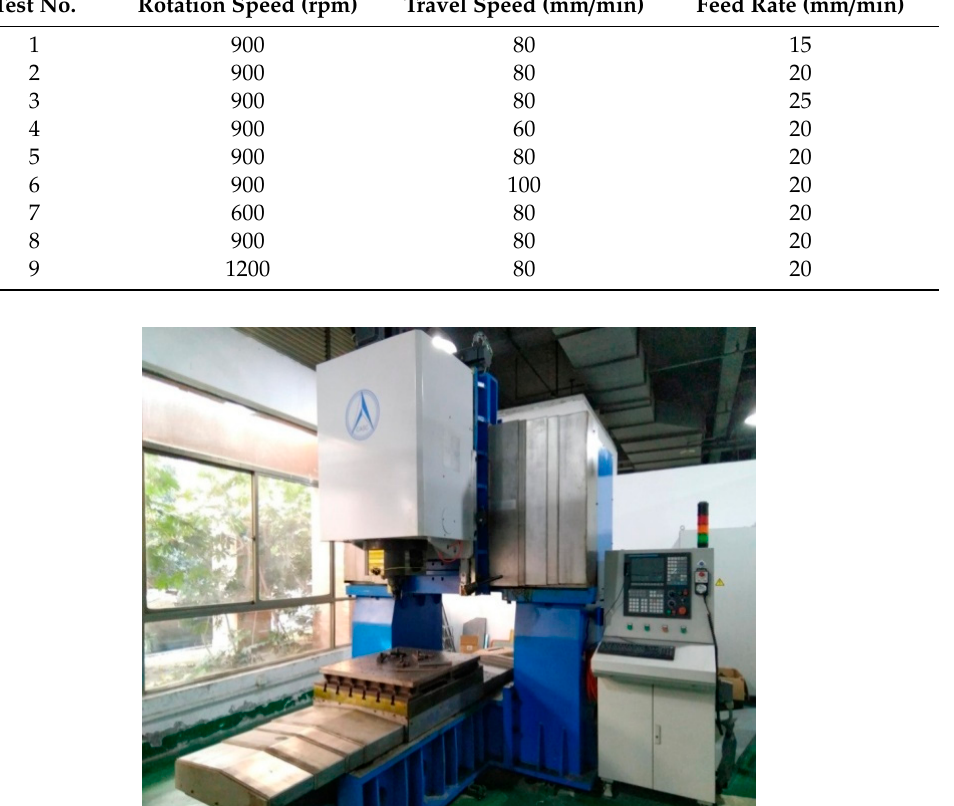
Figure 2. Friction stir welding equipment. Table 1. Chemical composition (in wt %) of the AA5083 Al alloy.